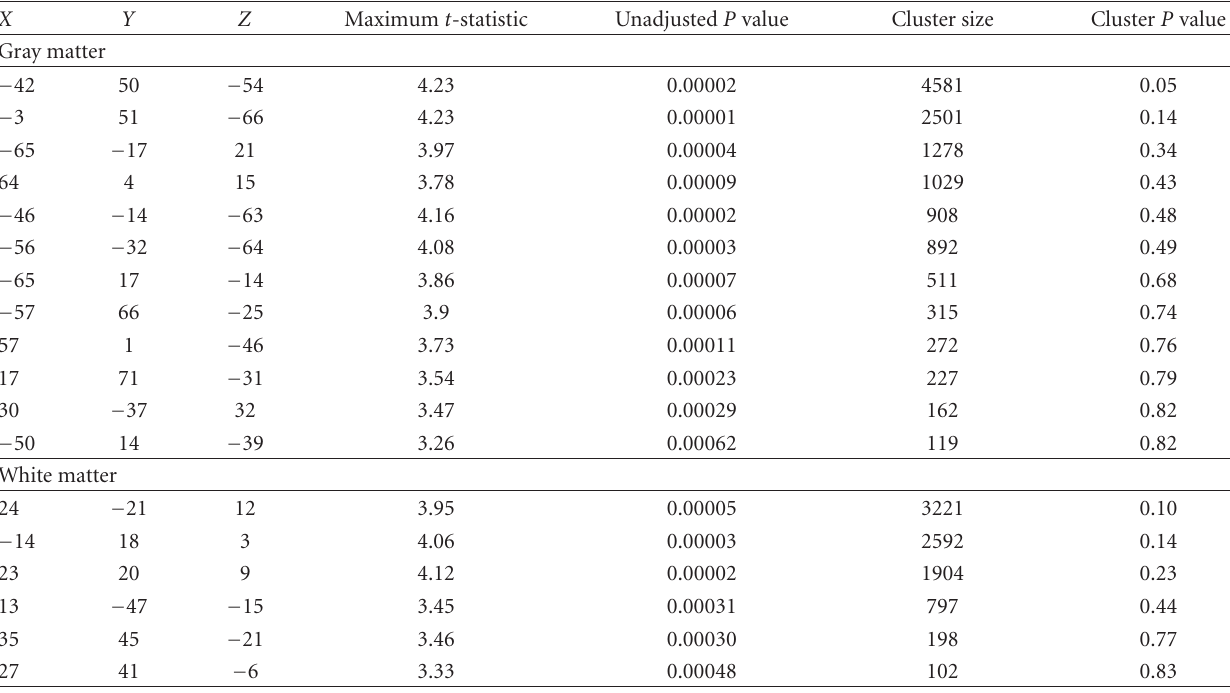
Table 4: Cluster statistics from voxel-wise analysis.